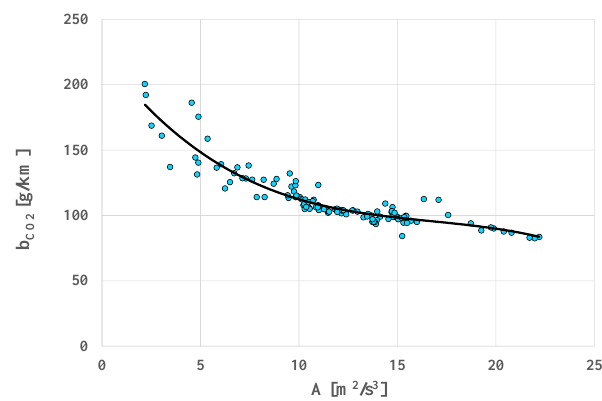
Fig. 21. Dependence of the average specific distance emissions of carbon dioxide on the average value of the absolute value of the product of vehi- cle velocity and acceleration in the Malta test